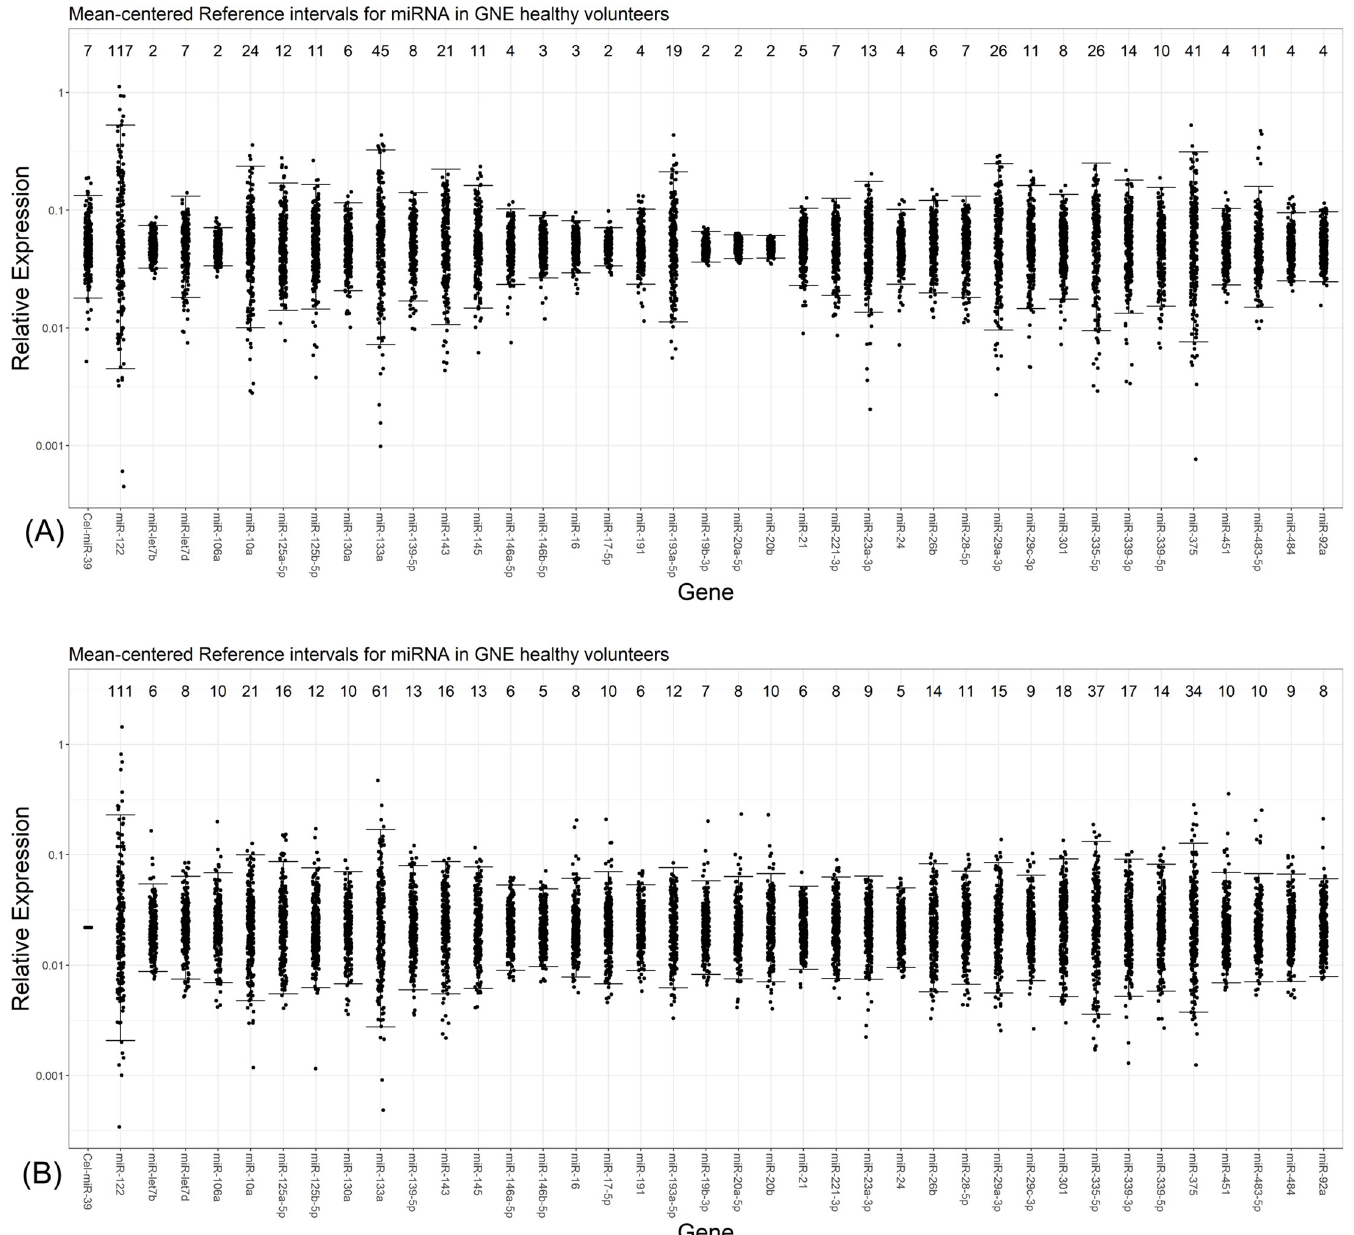
Fig 3. Mean-centered 95% confidence reference intervals of 38 abundant miRNAs relative to miR-122 in serum from healthy volunteers. The relative expression of 38 abundant miRNAs in human serum from healthy volunteers, including miR-122, are depicted as mean centered relative expression for miRNAs normalized using MiRA-norm (A) or exogenous C eleg miR-39 (B). The 95% reference intervals are represented in both panels with N = 240 samples per plot. The relative fold-change in the reference range for each 95% confidence reference interval is displayed above each